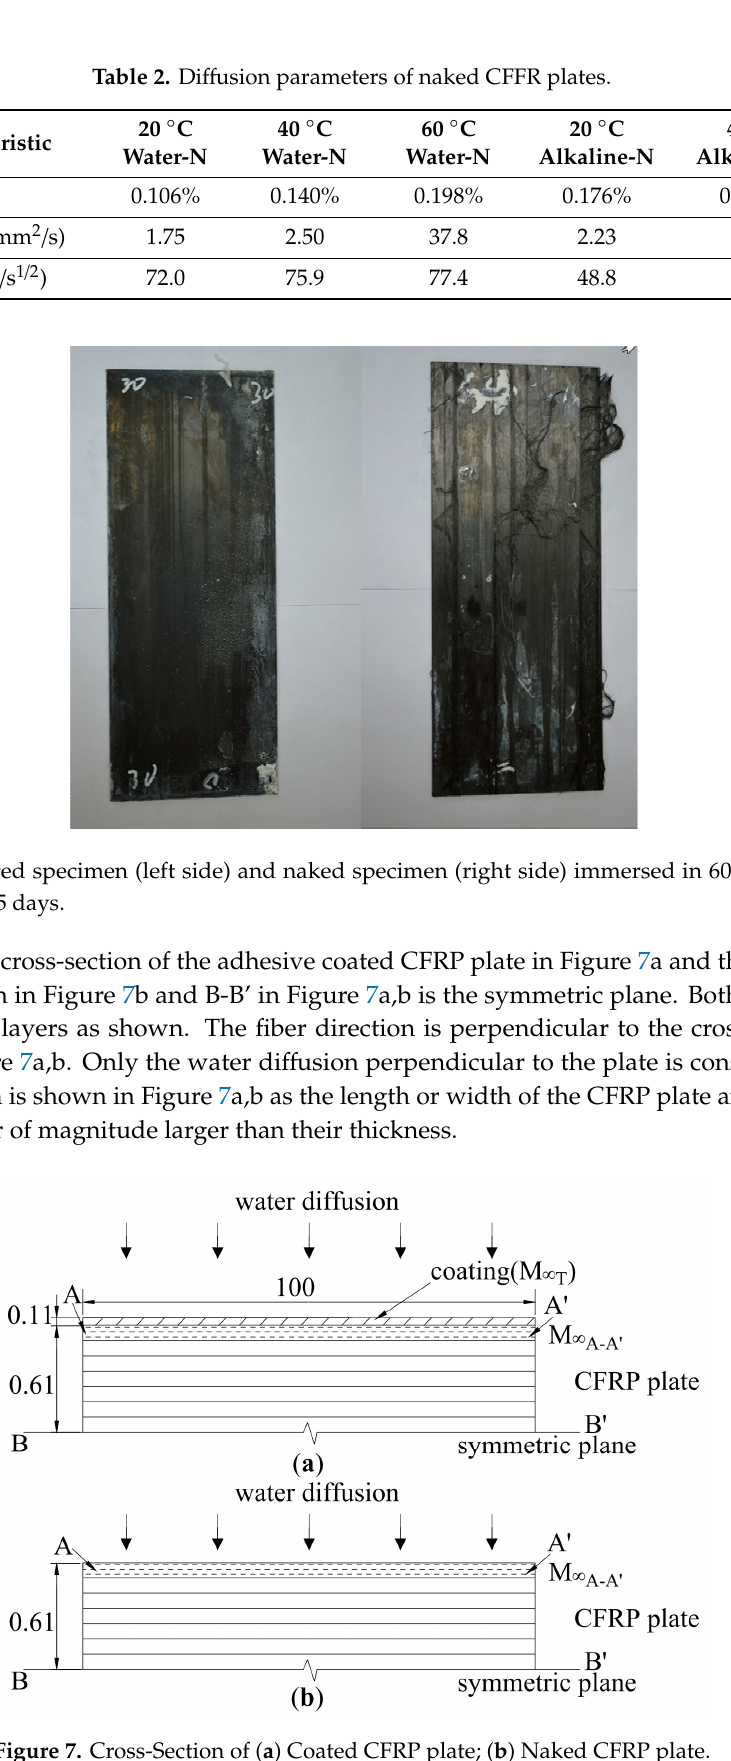
Figure 8. Water uptake of T1 adhesive. However, this is not the case for the subsequent aging process. The result of thermogravimetric analysis of naked specimens and coated specimens is shown in Figure 9 and the weight loss at 100 °C is due to the water evaporation which equals the water uptake of these specimens. Although due to the non-uniform water distribution in the specimens the thermogravimetric analysis cannot give accurately average water uptake of the specimens, it can still reflect the water uptake of specimens qualitatively. A comparison of naked specimens and coated specimens immersed in 20 °C or 60 °C water for 135 days shows that the adhesive coating can significantly slow down the water diffusion. For instance, for specimens immersed in 60 °C water for 135 days, naked specimen and coated specimen have water uptakes of 4.41% and 2.53%, respectively. As explained previously, the two cases in Figure 7a,b have the same diffusion parameter D in the initial stage. However, as shown in Figure 9, the two cases have different water uptakes after 135-day immersion. Hence, it can be concluded that the water diffusion parameter D may increase during immersion due to the gradual degradation of the interfacial bonding between fiber and resin matrix and hence D is not a constant value. The adhesive coating can significantly slow the degradation of the interfacial bonding between fiber and resin matrix and subsequently the water diffusion in specimens. 0